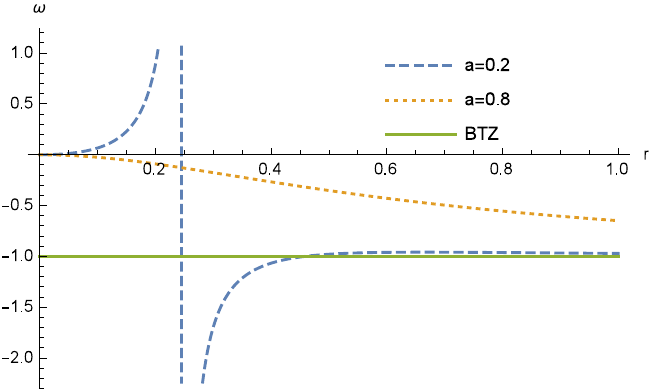
Figure 3. State parameter ω ( r ) . For this plot, we used M = 1 and l =